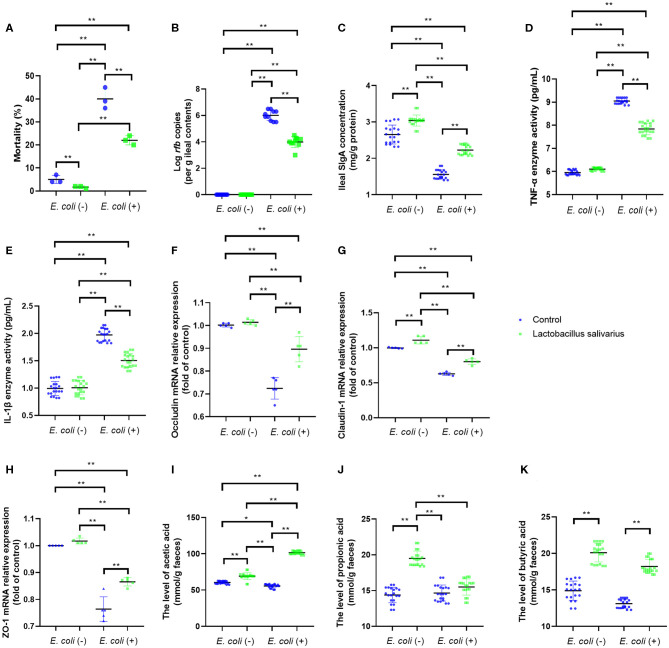
Effects of dietary Lactobacillus salivarius supplementation on the response of chickens to pathogenic Escherichia coli O78 challenge. (A) Mortality of the chickens following Escherichia coli O78 challenge, which was measured at 8 weeks of age (n = 3). Each point represents the result from an independent experiment and bars represent mean ± SD. (B)
Escherichia coli O78 colonization in ileal contents at 7 days post-Escherichia coli infection (n = 10). (C) Secretory IgA (sIgA) concentration of ileum mucosa, which was measured 7 days post-Escherichia coli challenge (n = 20). (D,E) Cytokines of ileal tissues, which were measured 7 days post-Escherichia coli O78 challenge (n = 20). (F–H) Tight junction related gene mRNA expression of ileum, which were measured 7 days post-Escherichia coli challenge (n = 5). (I–K) Influence of Lactobacillus salivarius on shorter-chain fatty acids (SCFAs) levels of feces, which were measured 7 days post-Escherichia coli challenge (n = 20). ** indicates P < 0.01. Each point represents a single bird and bars represent mean ± SD (B–K). Two-way ANOVA for repeated measurements, followed by Tukey tests. * indicates P < 0.05; ** indicates P < 0.01.